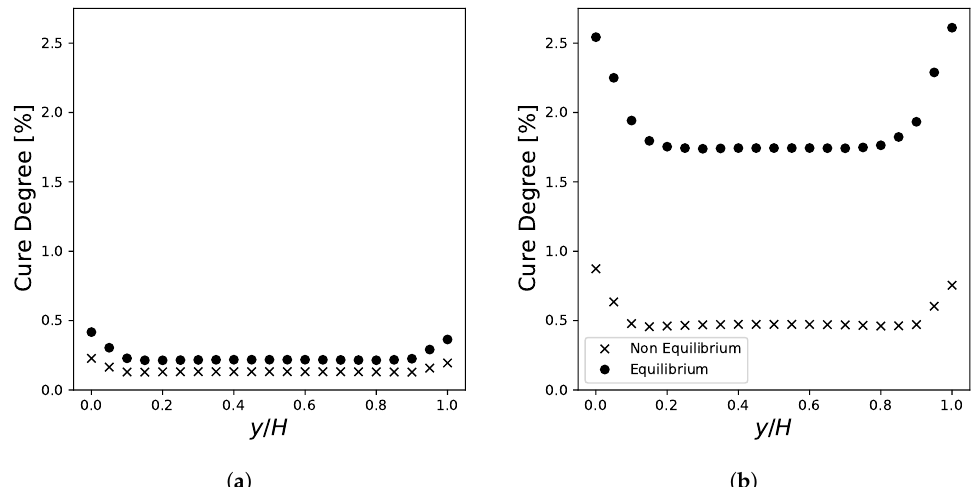
Figure 6. Cure degree development during infiltration for the thermal non-equilibrium and thermal equilibrium model at a location of ( a ) 25% and ( b ) 75% in the domain. Note that the legend in ( b ) is applicable to both